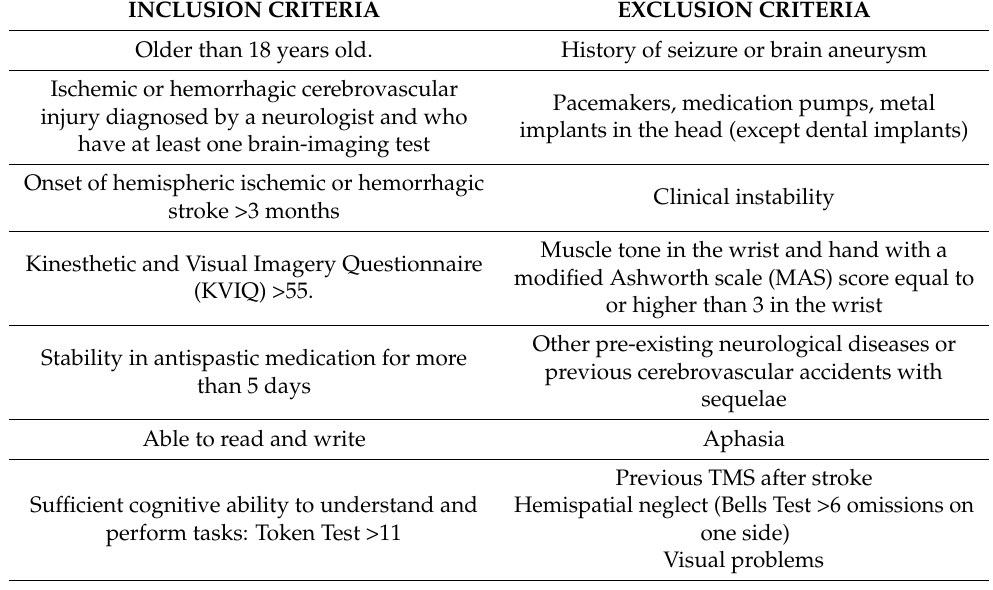
Table 1. Inclusion and exclusion